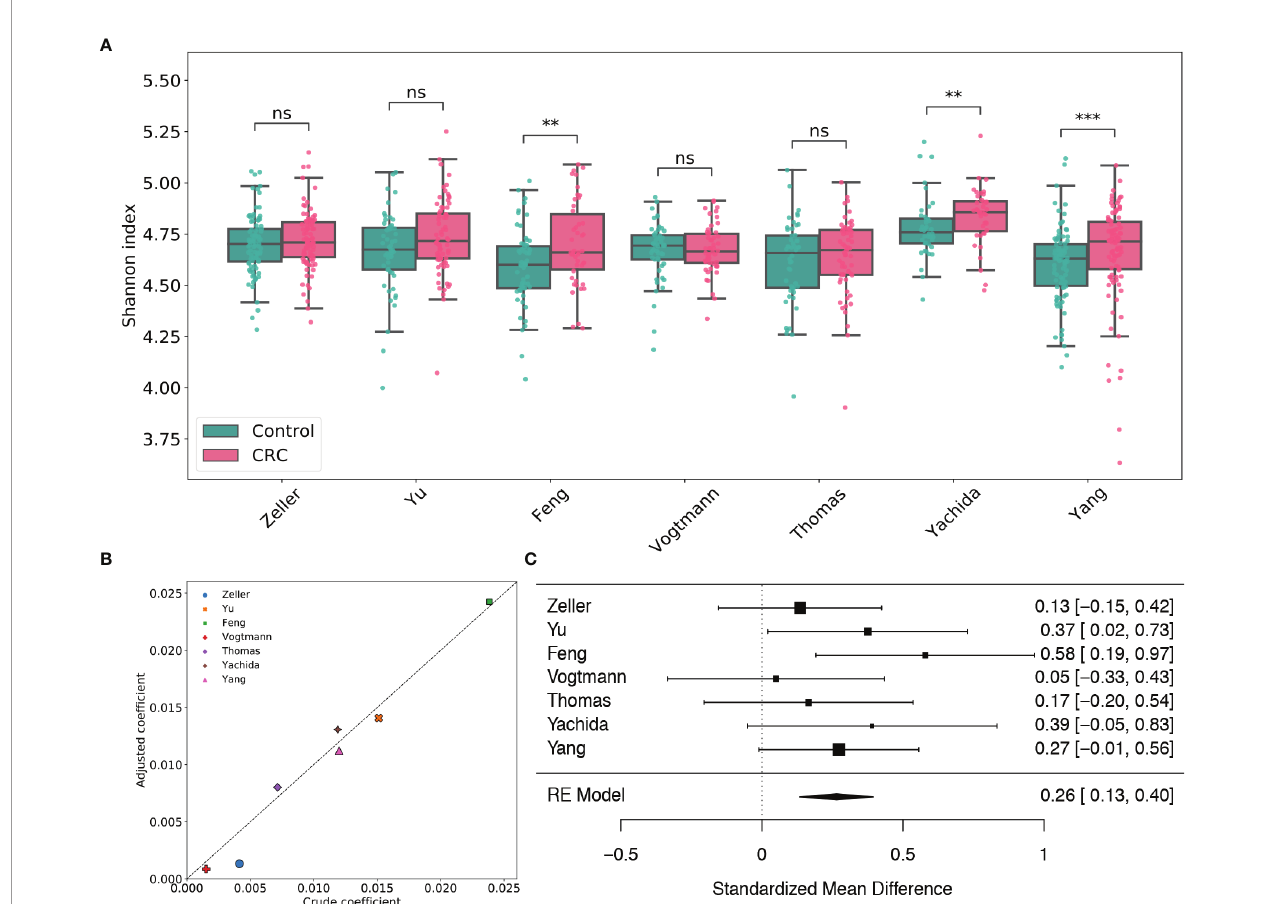
FIGURE 1 | Analysis of viral species Shannon diversity within each dataset. (A) Boxplots of viral species-level Shannon index for gut samples of CRC subjects and healthy controls strati fi ed by disease status in each dataset. BH adjusted p-values were calculated using the two-tailed Wilcoxon rank-sum test. ns: p> 0.05, *p< 0.05, **p< 0.01, ***p< 0.001. (B) Multivariate analysis of the adjusted impact of age, gender and BMI on Shannon diversity. (C) Forest plot showing effect sizes from a meta-analysis on species-level diversity. RE Model: Random effect